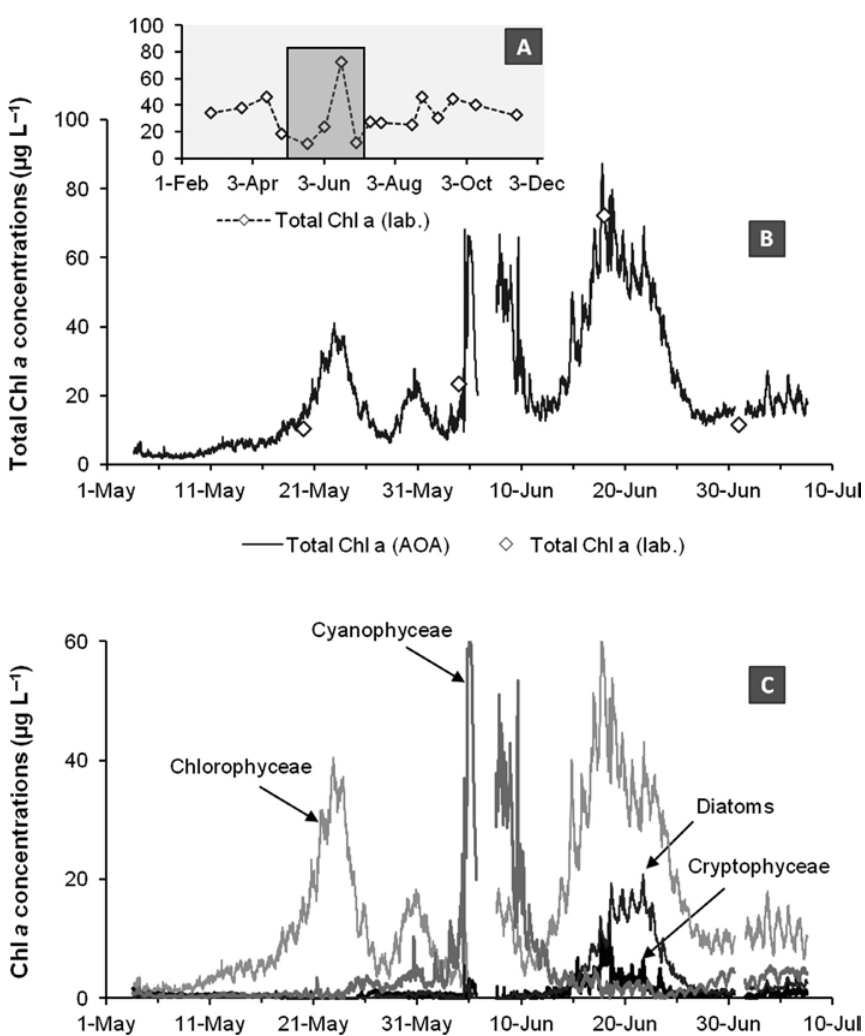
Fig. 5. Chlorophyll a concentrations (in m g L (cid:30) 1 ) in the overlying water of the pond. A, total concentrations determined by